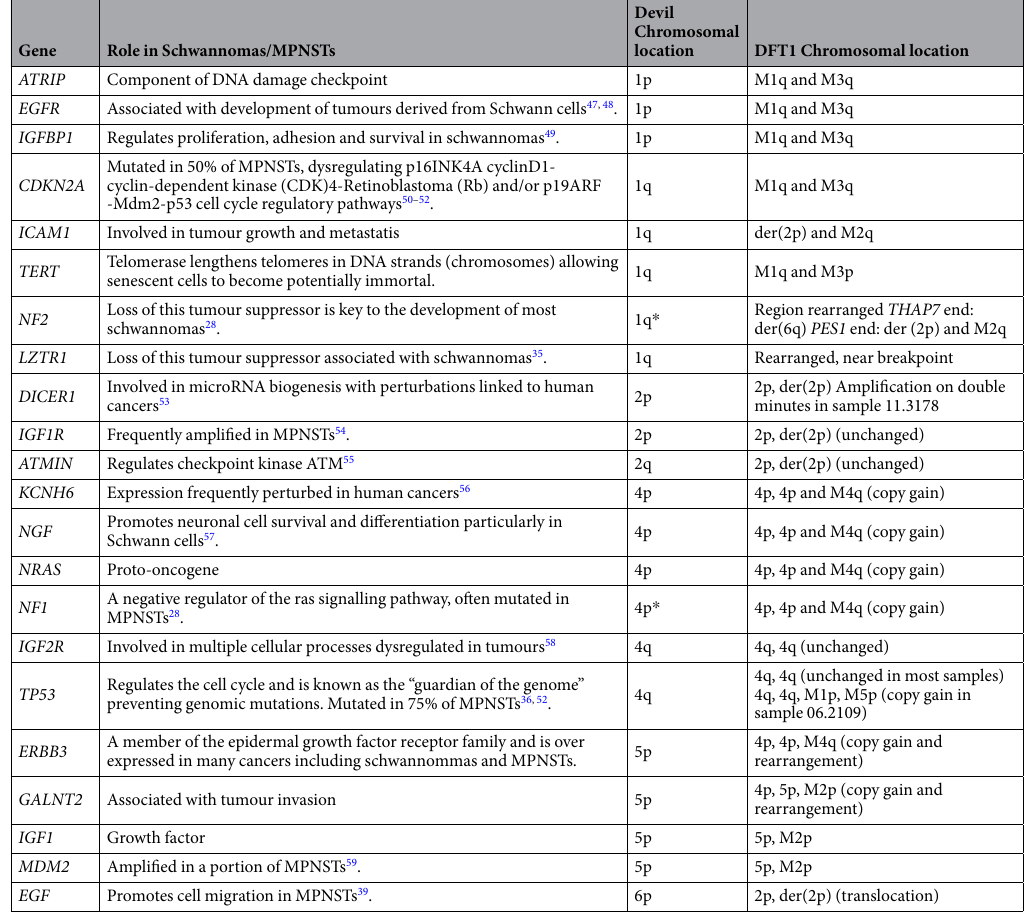
Table 1. Selected cancer-related genes. * NF1 and NF2 were not directly